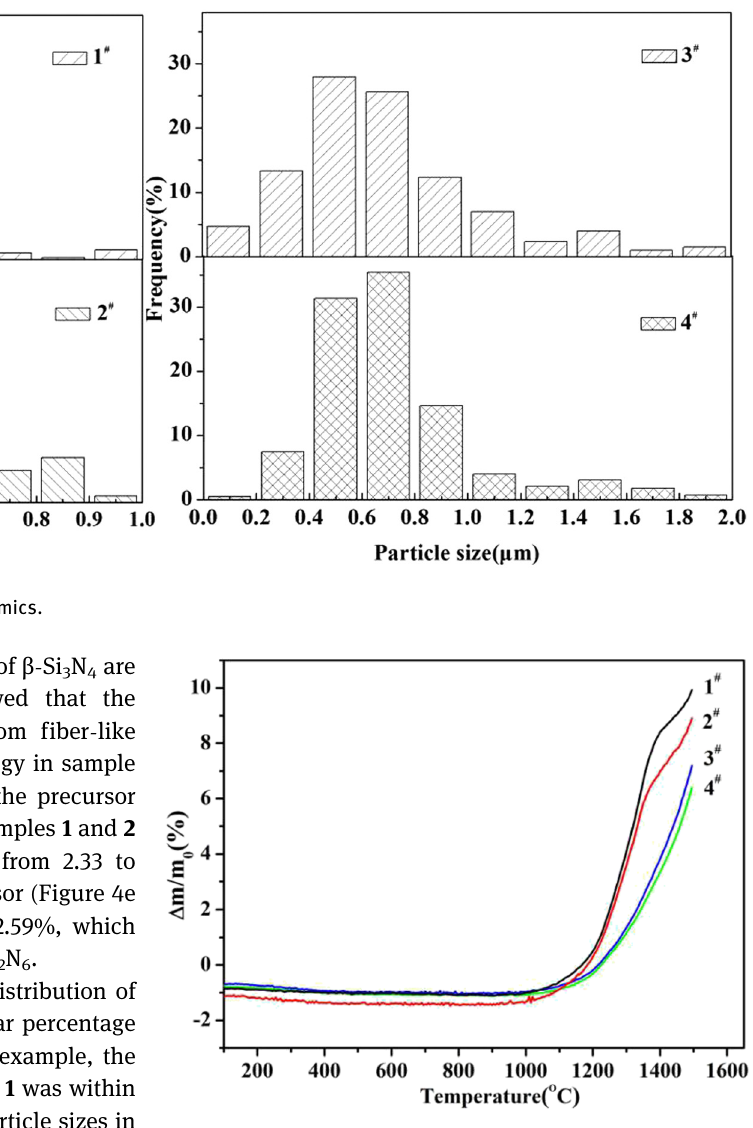
Figure 6: Non - isothermal oxidation curves of Si 4 Al 2 O 2 N 6